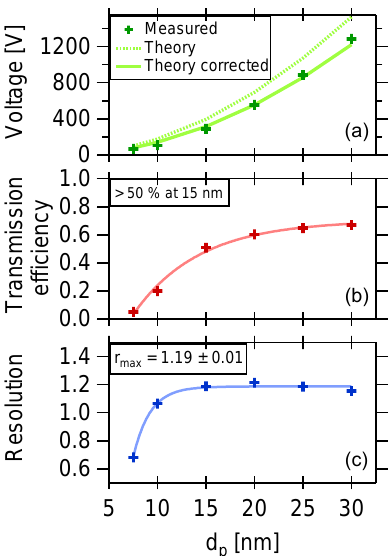
Figure 5. Summary of DMA performance parameters. The DMA is optimized for a coarse resolution and high transmission in order to collect a maximum amount of particle mass while still allowing size